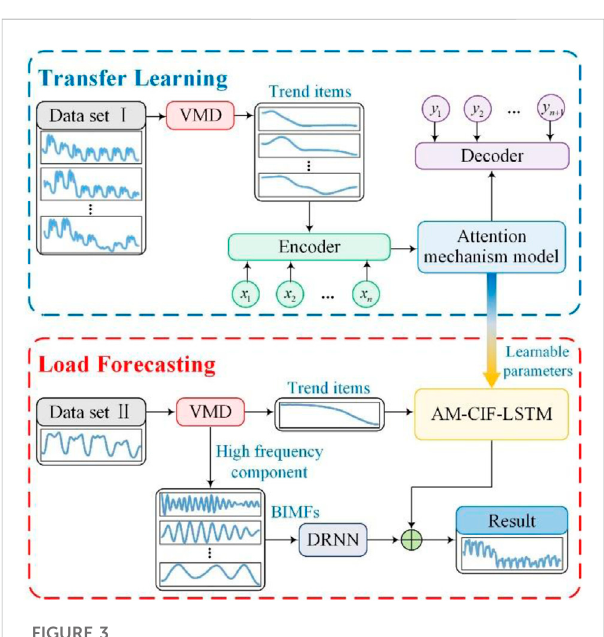
FIGURE 3 Framework of the proposed load forecasting